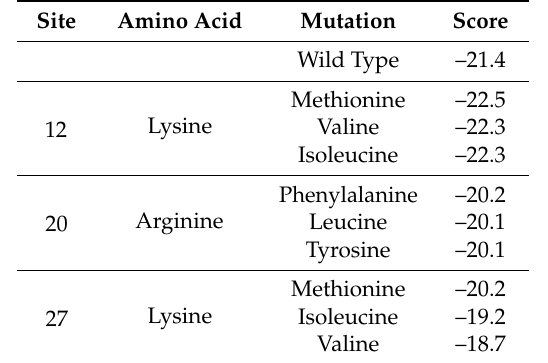
Table 2. The Rosetta Design Server-based stability scores associated with each trypsin cleavage site. A lower score predicts a higher stability for the mutation. Thus, the most stable mutations, which did not belong to the trypsin recognition sequence, were chosen for the subsequent analog designs.